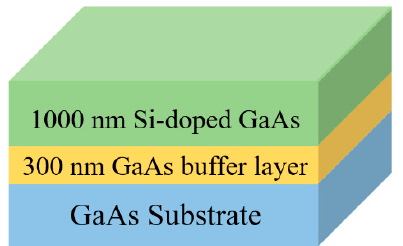
Figure 1. The schematic diagram of Si-doped Gallium Arsenium (GaAs) sample.